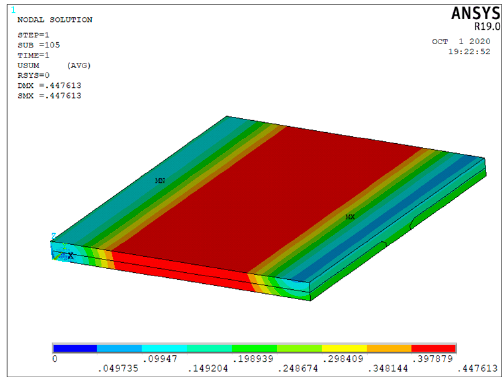
Figure 27. The total displacement stress cloud diagram of CLHCPCS under the ultimate load.